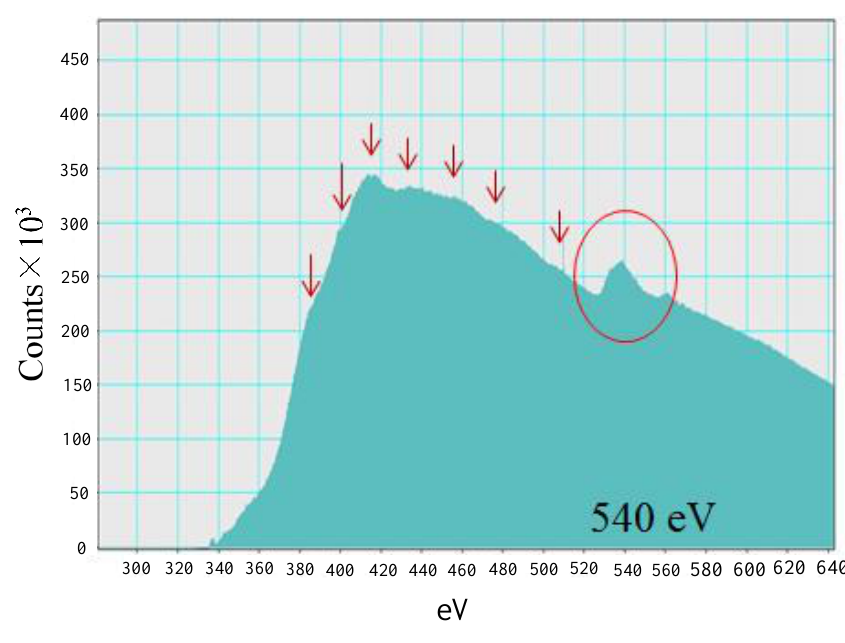
Figure 5. STEM and EDS analysis result of Pd / TiO 2 film coated on netlike glass disc.